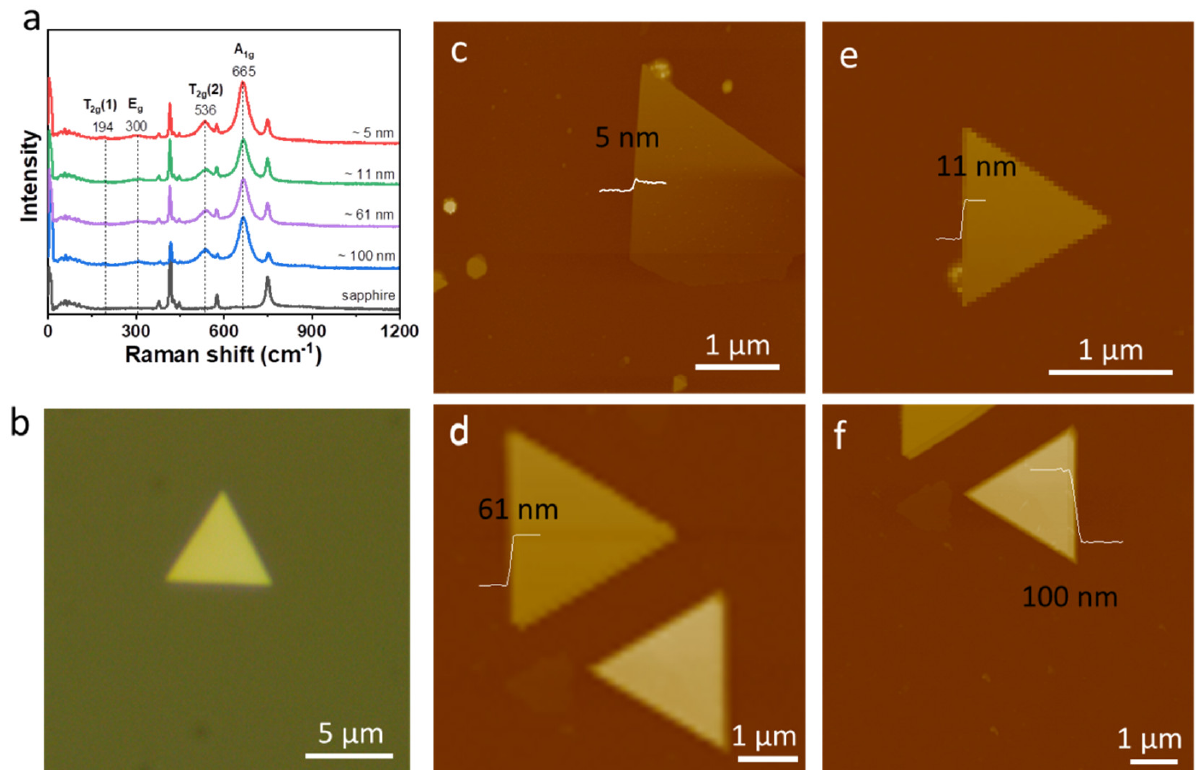
Figure 3. ( a ) Raman spectra of triangle Fe 3 O 4 nanosheets with various thicknesses; ( b ) optical microscopic images of triangle Fe 3 O 4 nanosheet; ( c – f ) the AFM images of triangle Fe 3 O 4 nanosheets.